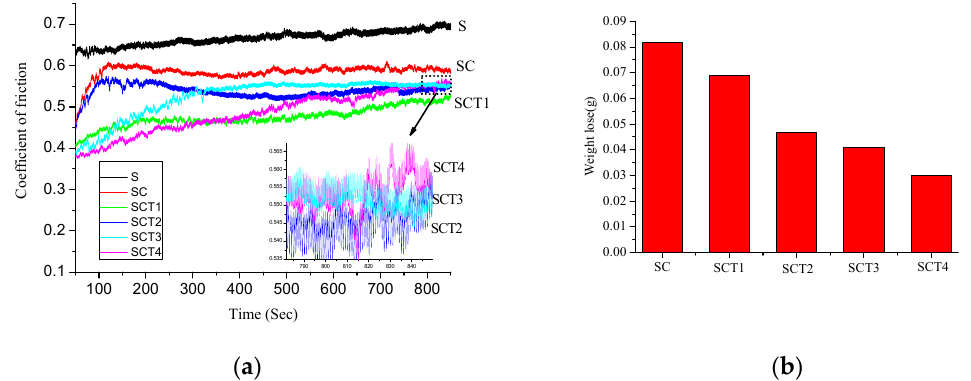
Figure 5. ( a ) Results of friction test: ( a ) COF, ( b ) weight loss of all samples.